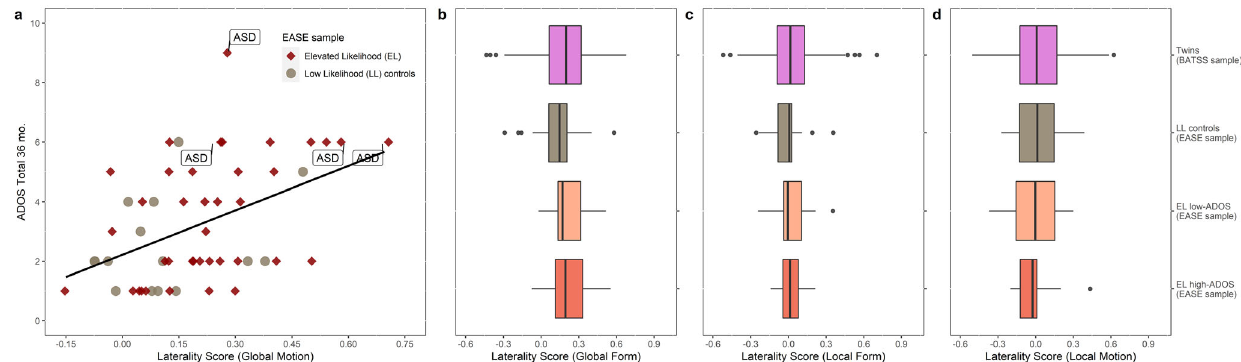
Fig. 3 ASD diagnoses among EASE participants and group differences of Laterality Scores in the three other stimulus conditions. a Laterality Scores in the Global Motion condition versus ADOS-2 CS total scores at 36 months from EASE children who partook in the DSM-5 (Diagnostic and Statistical Manual of Mental Disorders 5ed) diagnostic session ( n = 55), highlighting very few positive cases ( n = 4) with a con fi rmed ASD diagnosis. b No difference in the mean Laterality Scores between the four groups of infants during global form processing (all p > 0.25). c . and d . Similarly, mean Laterality Scores between the four infant groups were found to be very similar during both the local form processing (all p > 0.50) and local motion processing (all p > 0.50), respectively. Boxplots show the sample median, and the fi rst and third quartiles; whiskers show minimum and maximum (±1.5 s.d.); dots are outliers (±1.96 s.d.); sample sizes are the same as reported in Fig. 2b ( n EL high-ADOS = 14, n EL low-ADOS = 25, n LL = 16, n BATSS = 452). Complete statistics